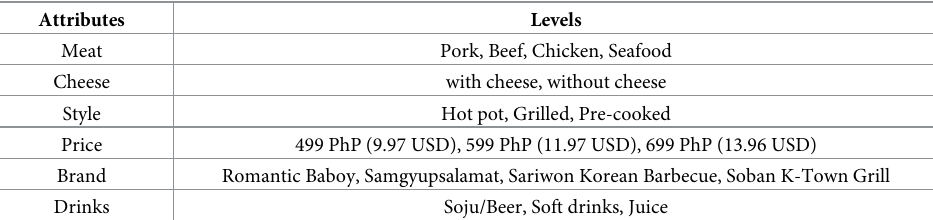
Table 1. Attributes and